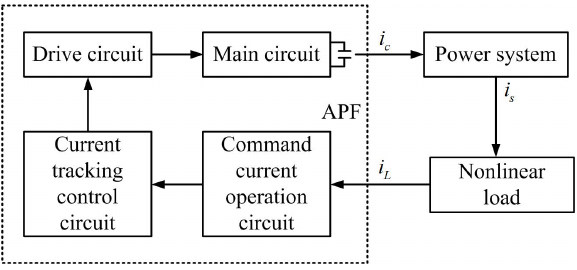
Fig. 1. Basic schematic diagram of active power filter generally divided into voltage-type APFs and current-type